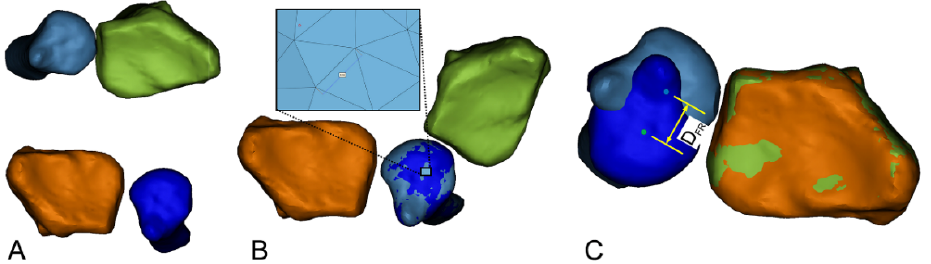
Figure 1. Measurement of movement distance of the points on the articular surface of the ulnar head during forearm rotation. ( A ) The 3D models of pronated and supinated wrists. ( B ) Using the ICP algorithm, the models were superimposed so that the two ulnar heads were in the same position. Numerous points were set on the surface of the ulnar head of the pronated model, with a mean distance of 0.2 mm between the nearest two points. ( C ) Then, the pronated model was repositioned so that the radii of the pronated model and the supinated model were superimposed. The distance the points moved during the reposition (that is, the distance between the same points on the ulnar head in supination and pronation, D FR ) was measured three-dimensionally. The rotation center (RC) was defined as the point with the shortest D FR . The isometric point (IP) was defined as a RC with a D FR of less than 0.2 mm.